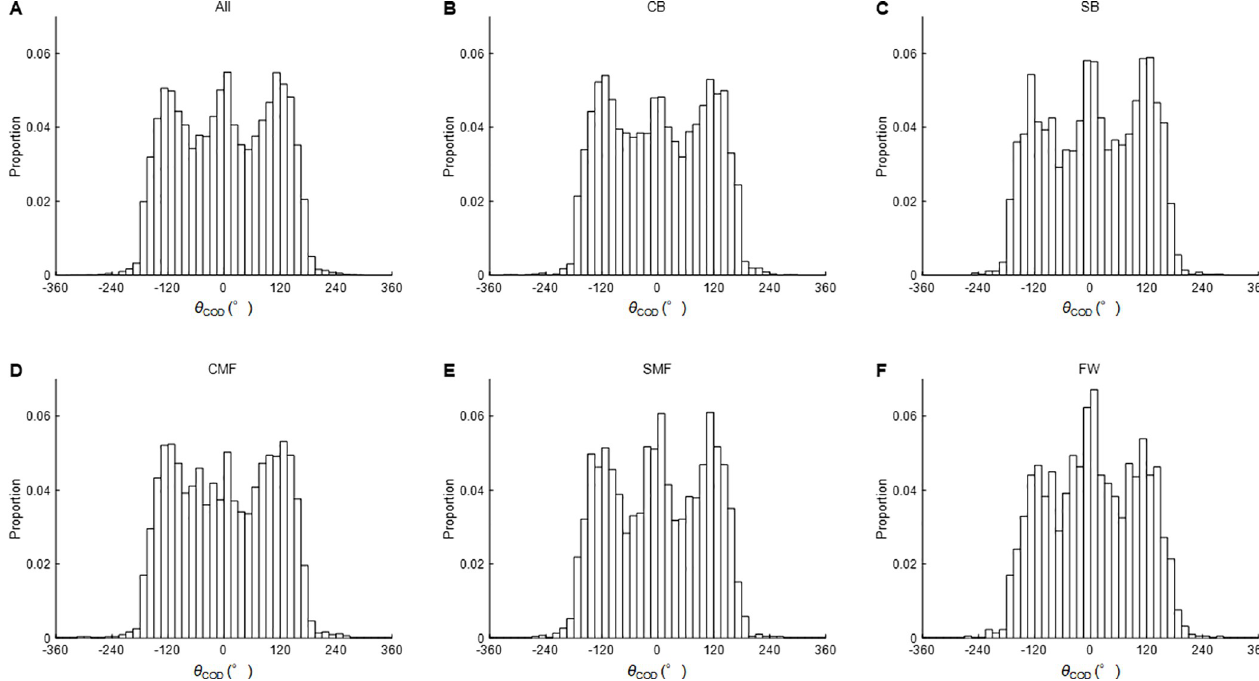
Fig 3. Relative frequency distribution of θ COD per match. Each bin is set at every 15˚. A: all positions, B: center backs (CB), C: side backs (SB), D: central midfielders (CMF), E: side midfielders (SMF), F: forwards (FW).